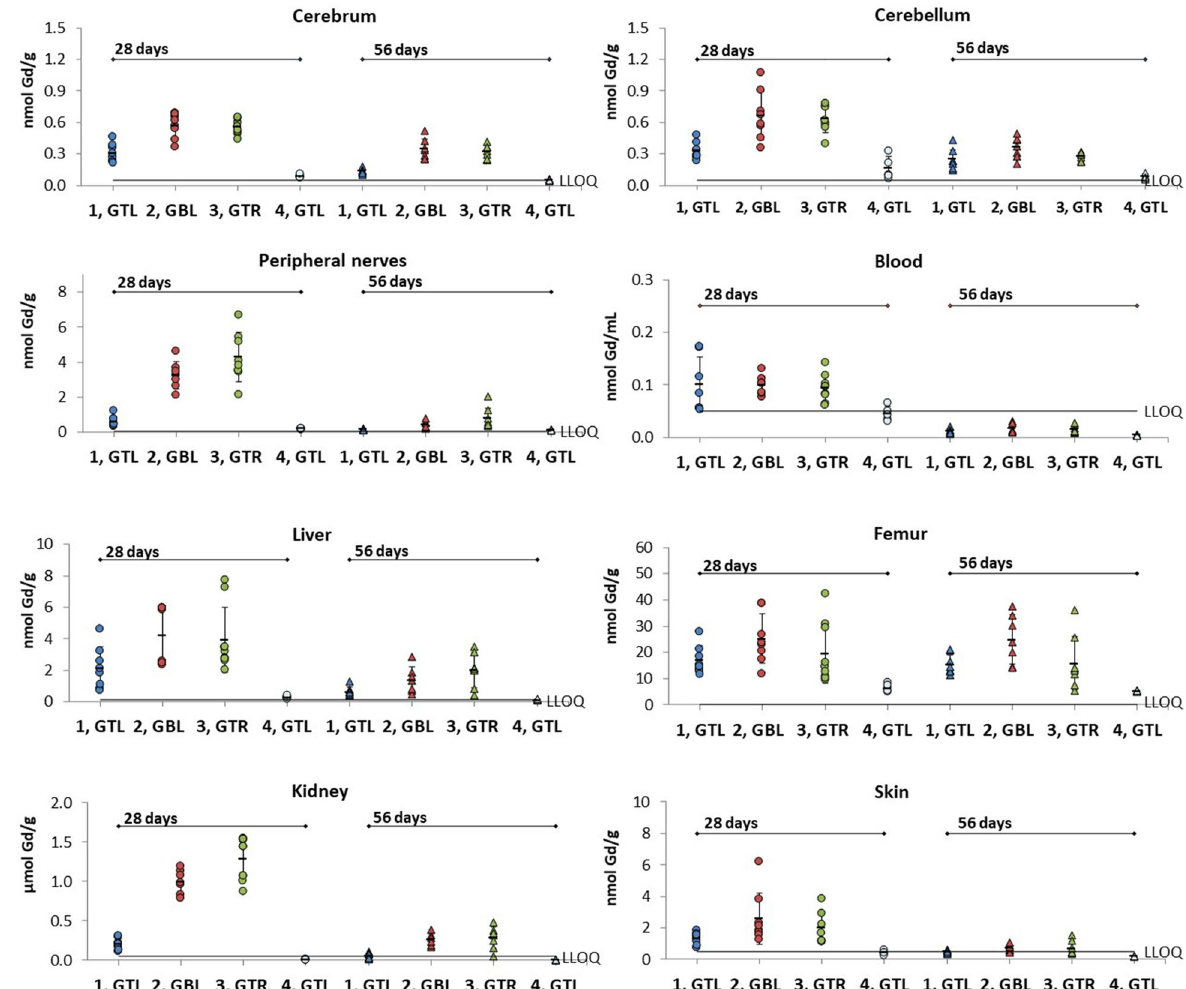
Fig. 3 Gd content in different tissues. Gd content determined by inductively coupled plasma/mass spectrometry (individual values, mean standard deviation) in different tissues at day 28 and day 56 post-treatment. The error bars represent the standard deviation of ± measurements within the groups. On the x axis: group 1, gadoteridol (1, GTL), n 7 or 8; group 2, gadobutrol (2, GBL), n 6, 7, or 8; group 3, = = gadoterate (3, GTR), n 7, 8, or 9; and group 4, (4, GTL), n 4 or 5). On the y axis: nmol (µmol for kidney) Gd/g of wet tissue (or mL for = =